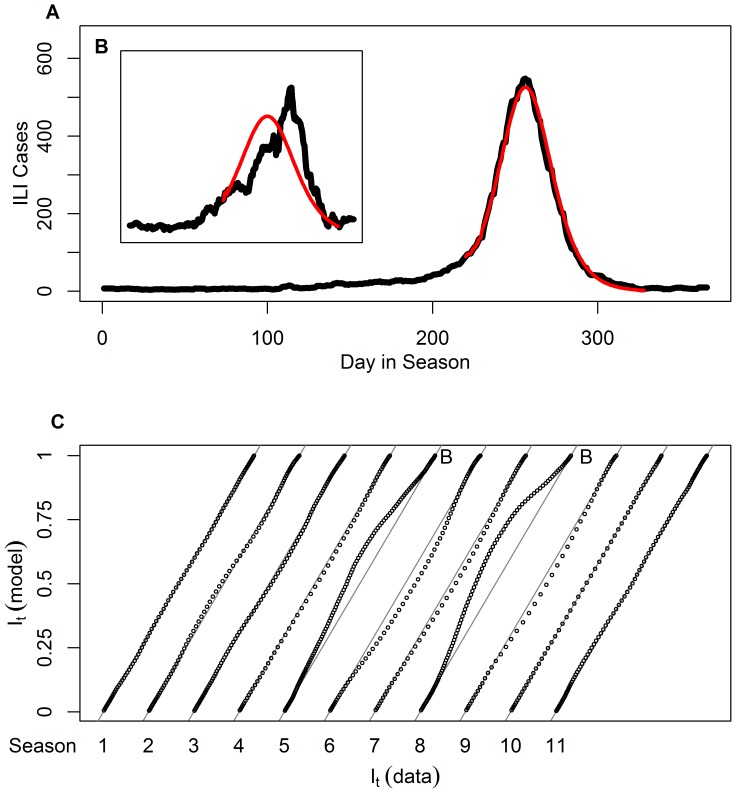
Fits of SIR models to observed ILI incidence.Top (A): model fits to the 2007–2008 season (main) and the 2002–2003 season (inset (B)). Bottom(C): model fits to all eleven seasons 1998–1999 to 2008–2009 where observed cumulative infectives is plotted as a function of model SIR cumulative infectives (dots). Diagonal lines indicate a perfect fit of the model to the data; Day 1 in each season corresponds to June 1st. Time length of each epidemic varies from season to season due to differences in the start and end date of the best-fitting model.